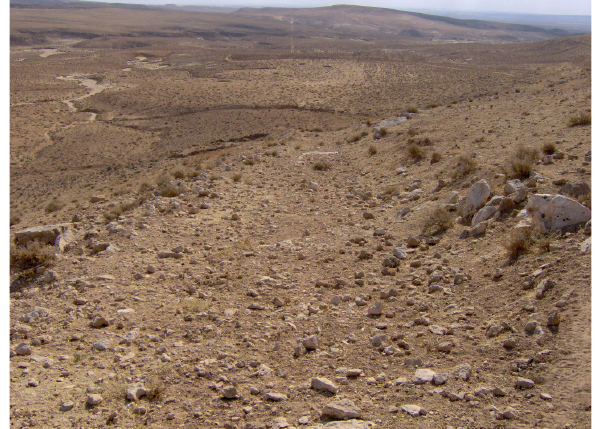
Figure 14. The via principalis leading to the Roman military camp K 1 in Ash-Shujiri in central area of Jebel